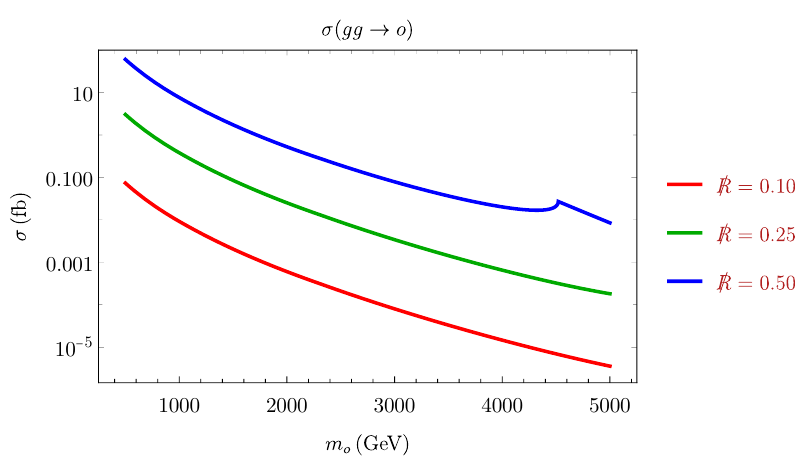
Figure 10. Cross sections of single pseudoscalar sgluon production by gluon fusion in Benchmarks